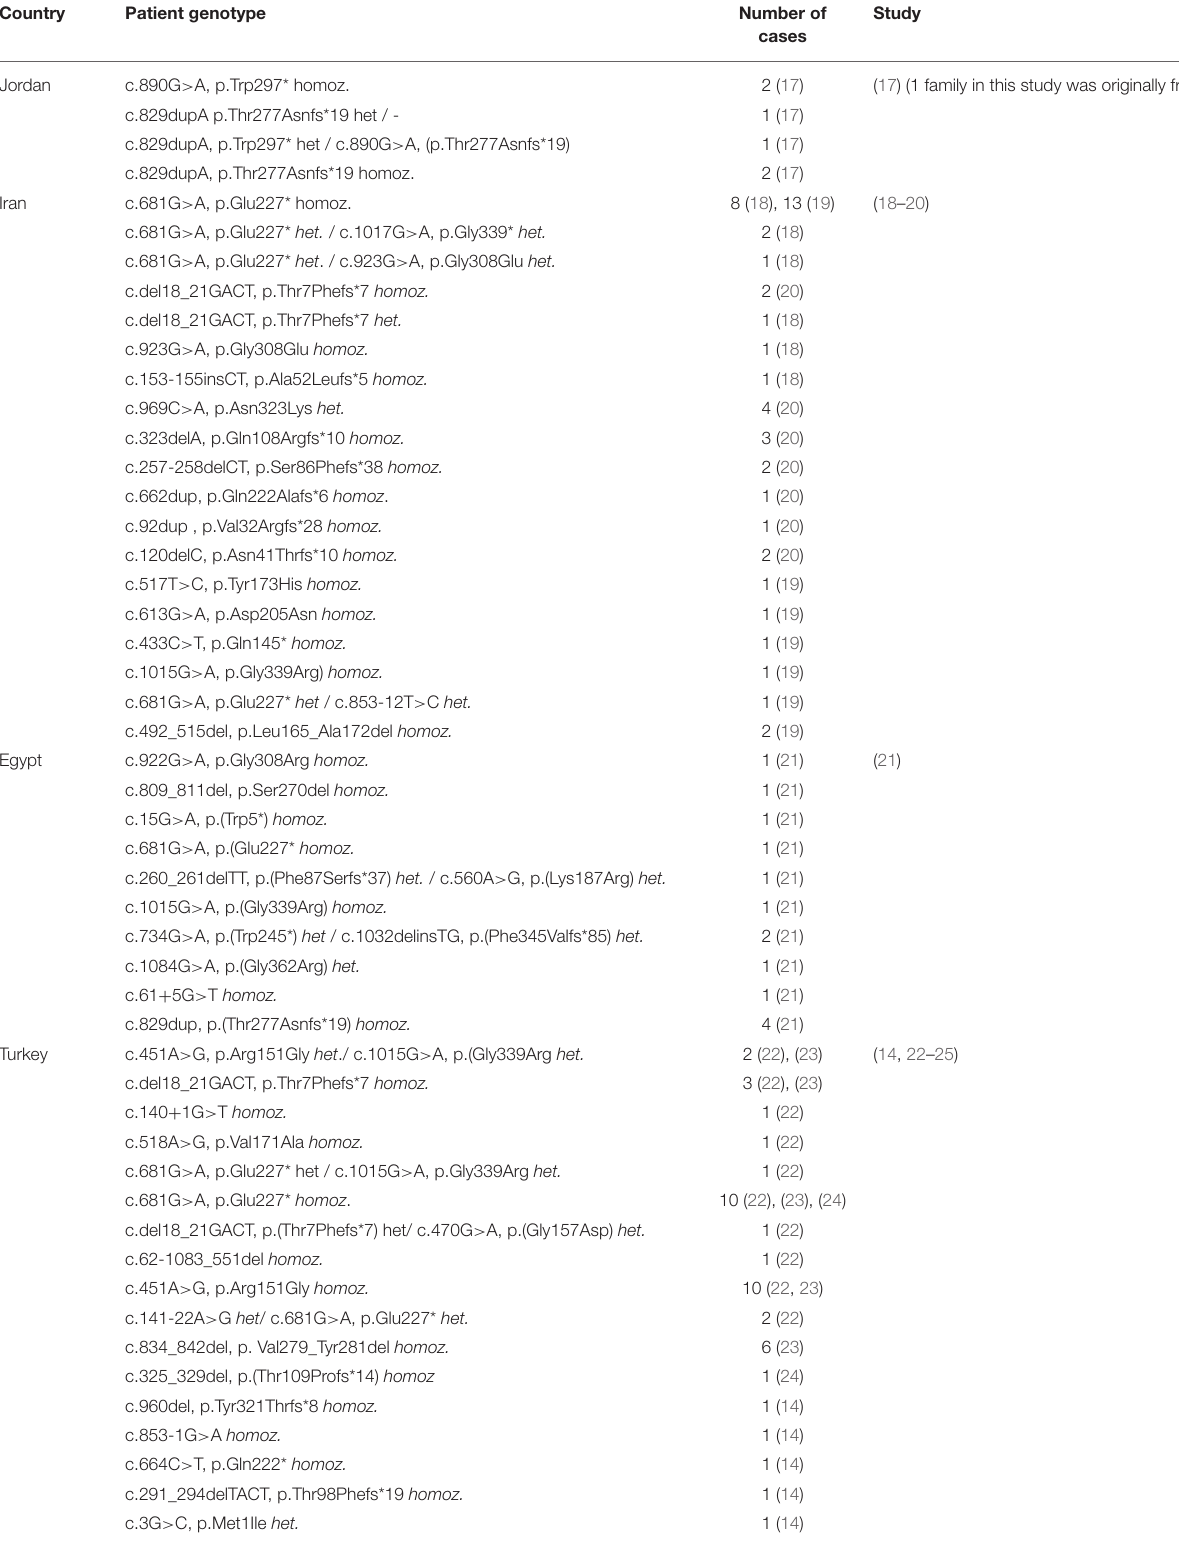
TABLE 1 | Summary of previously published CTNS causing variants in patients from the Middle-East.